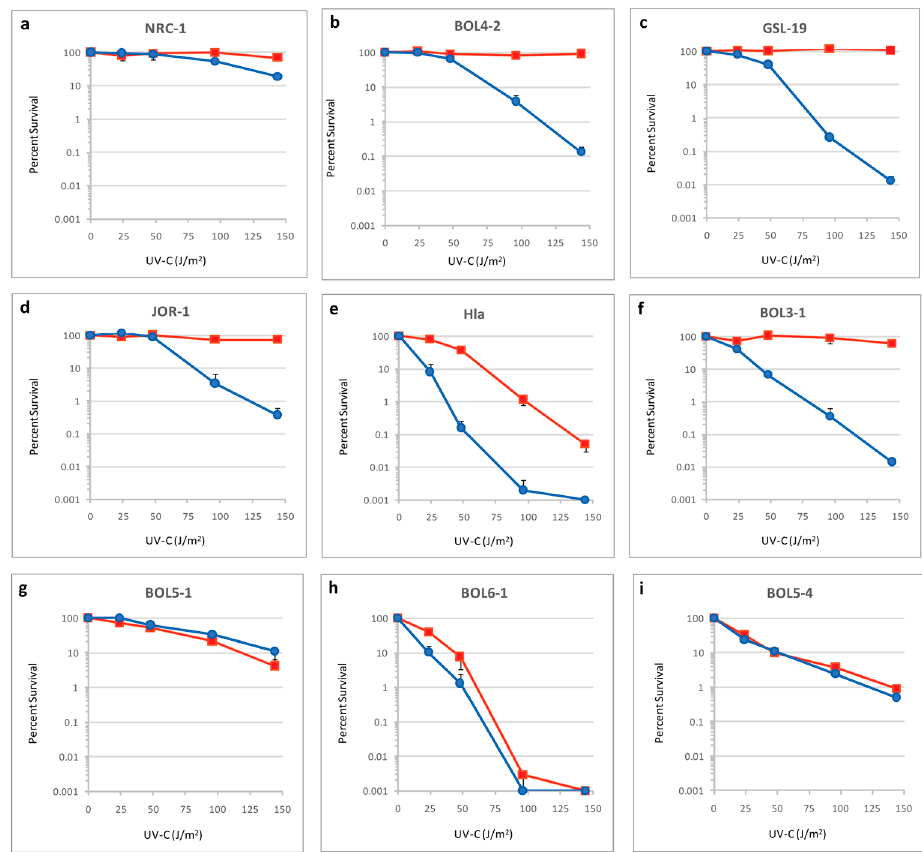
Figure 3. Survival of diverse Haloarchaea after UV irradiation. Shown are plots of percent survival of different strains versus dose of 254 nm wavelength light (24 to 144 Joules per meter squared, J/m 2 ), with (red lines) or without (blue lines) exposure to photoreactivating light: ( a ) Halobacterium sp. NRC ‐ 1; ( b ) Halobacterium sp. BOL4 ‐ 2; ( c ) Halobacterium sp. GSL ‐ 19; ( d ) Salarchaeum sp. JOR ‐ 1; ( e ) Halorubrum lacusprofundi (Hla); ( f ) Halorubrum sp. BOL3 ‐ 1; ( g ) Haloterrigena salifodinae BOL5 ‐ 1; ( h ) Natrinema pallidum BOL6 ‐ 1; ( i ) Natrinema versiforme BOL5 ‐ 4.